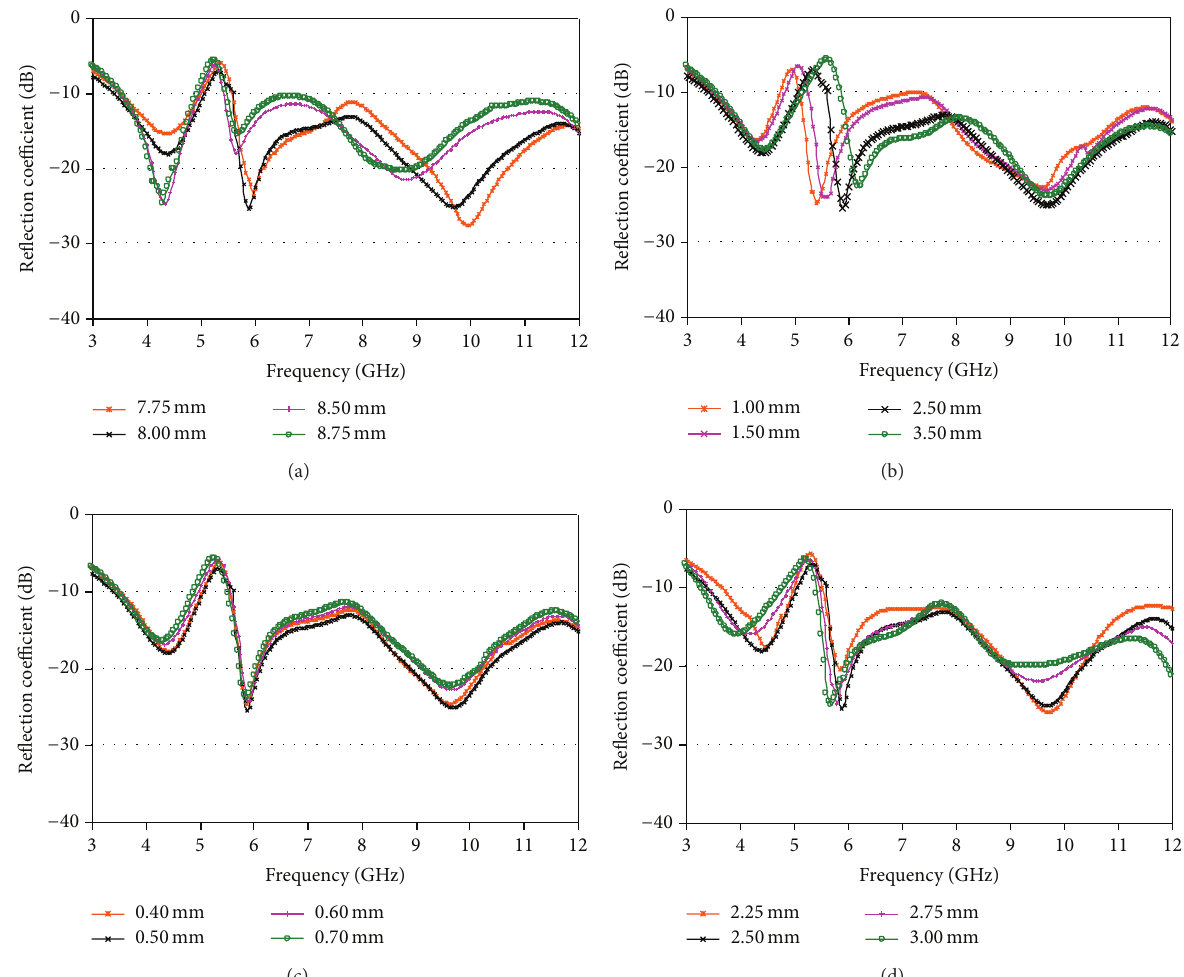
Figure 4: Effects for different values of (a) 𝑅 , (b) 𝑔 1 , (c) 𝑑 1 , and (d) 𝑀 𝑓 on the simulated reflection